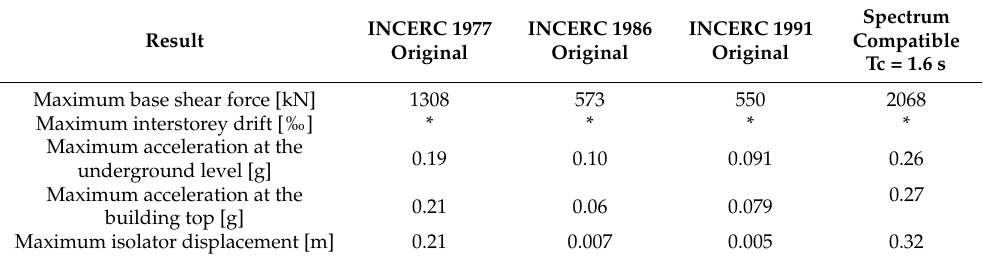
Table 5. Results from dynamic non-linear analysis, base-isolated